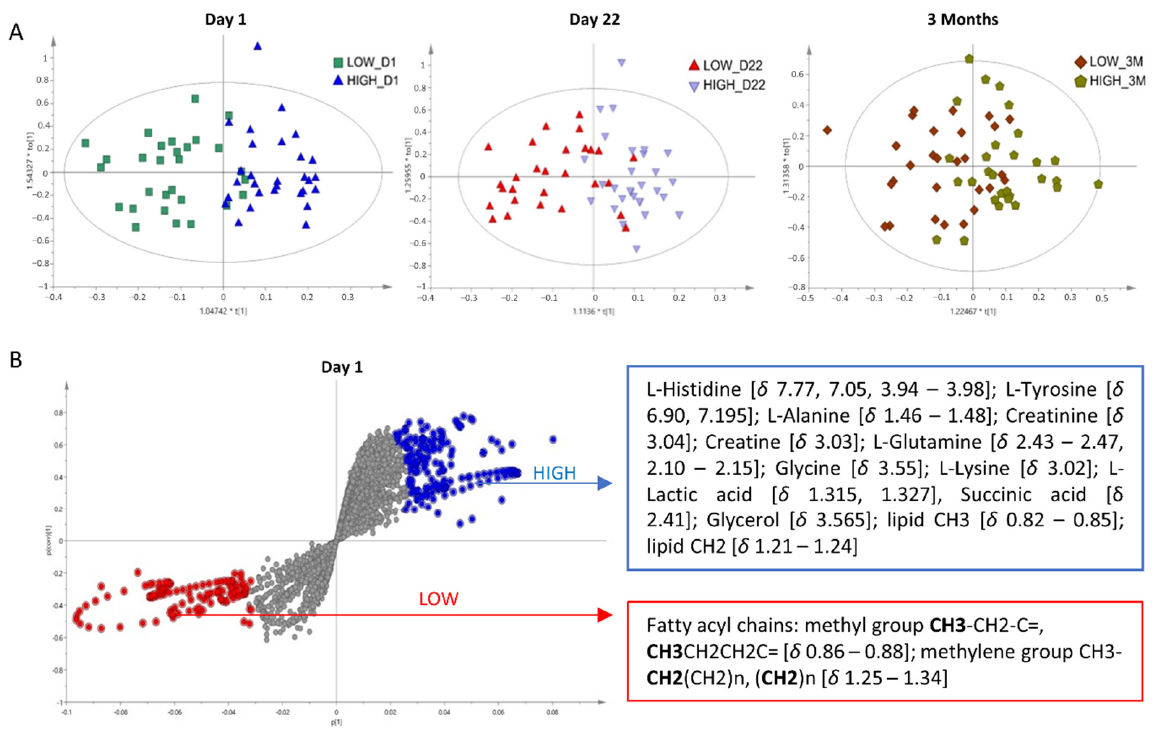
Figure 3. NMR Multivariate Analysis. ( A ) Scores plots obtained from the OPLS-DA analysis of NMR CPMG from plasma samples of high vs. low responders at Day 1, Day 22 and 3 Months. The two groups are discriminated in all time points, with the discrimination being clearer at Day 1 and Day 22. ( B ) S-plot obtained from the OPLS-DA of NMR CPMG from plasma samples of high vs. low responders after first dose at Day 1. Spectral variables on the top-right corner (blue) are considered significantly increased in the high responders, while those on the lower-left corner (red) are increased in the low responders. Metabolites with p and p(corr) ~0 (colored in grey) do not significantly impact the separation. Significant spectral variables and their assigned metabolites are shown.